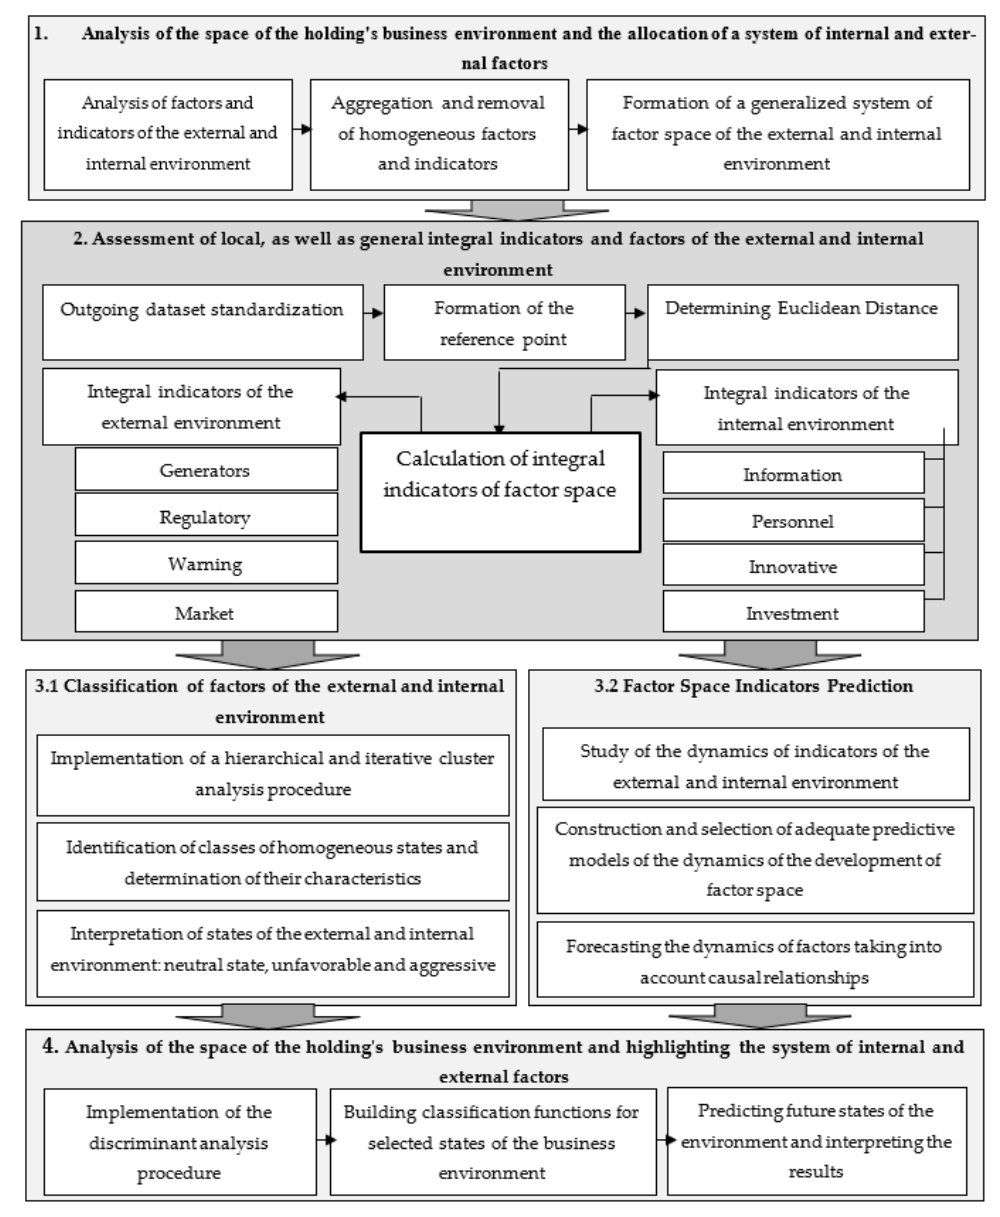
Figure 1. Algorithm for assessing the state and degree of influence of the business environment on the implementation of the financial strategy of a Russian energy holding.